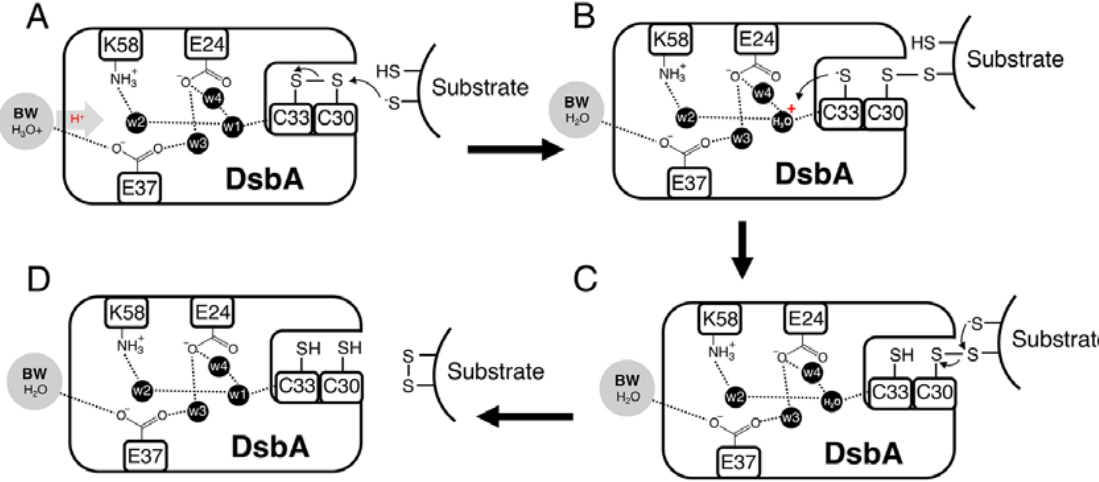
Figure 6. Proposed catalytic mechanism of DsbA. ( A ) Protonated bulk water (BW) donates a proton through the hydrogen-bonded proton wire to w1, which is hydrogen-bonded to the backbone amide of the DsbA C -terminal cysteine (C33 in EcDsbA). ( B ) A substrate cysteine in the thiolate form attacks the sulfur atom of the N -terminal cysteine of the oxidised CXXC active site (C30 in EcDsbA), resulting in the formation of an intermediate disulphide-bonded DsbA-substrate complex. For the reaction to proceed in the forward direction and avoid futile redox cycles, stabilisation/protonation of the DsbA C -terminal cysteine (C33 in EcDsbA) is required. We propose this could be achieved by C33 abstracting a proton from the nearby w1. ( C , D ) The mixed disulphide is then resolved by a deprotonated substrate cysteine, after which the oxidised substrate and reduced DsbA are